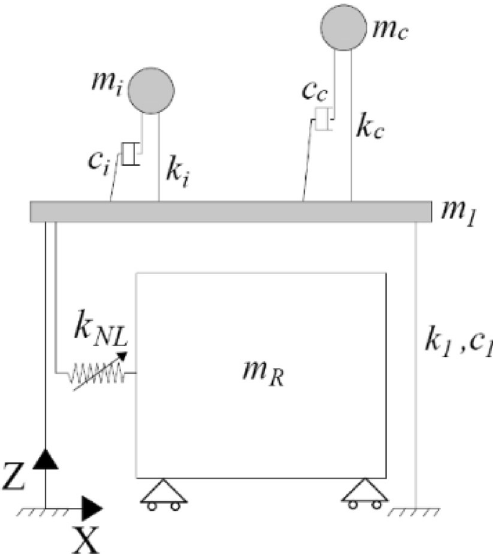
Figure 3. Metafoundation-tank coupled system model: condensed mass system